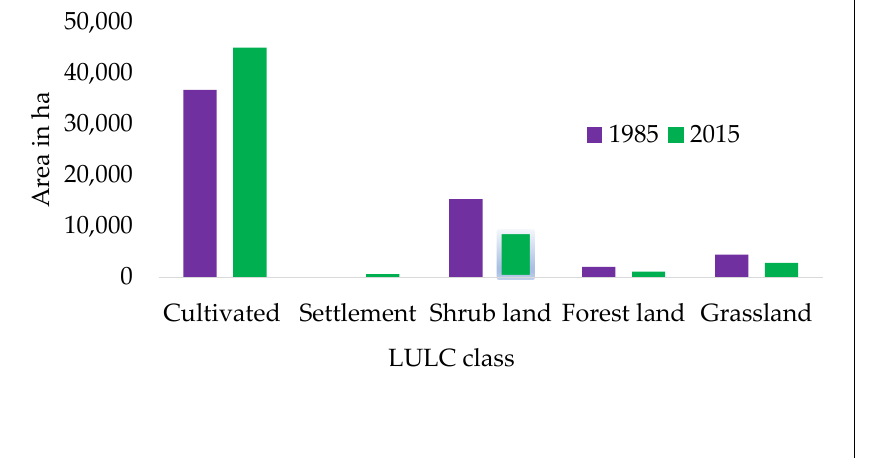
Figure 3. LULC changes from 1985 to 2015 in Andassa watershed, Ethiopia (Source of data: Gashaw et al. [9], but figure done by authors).